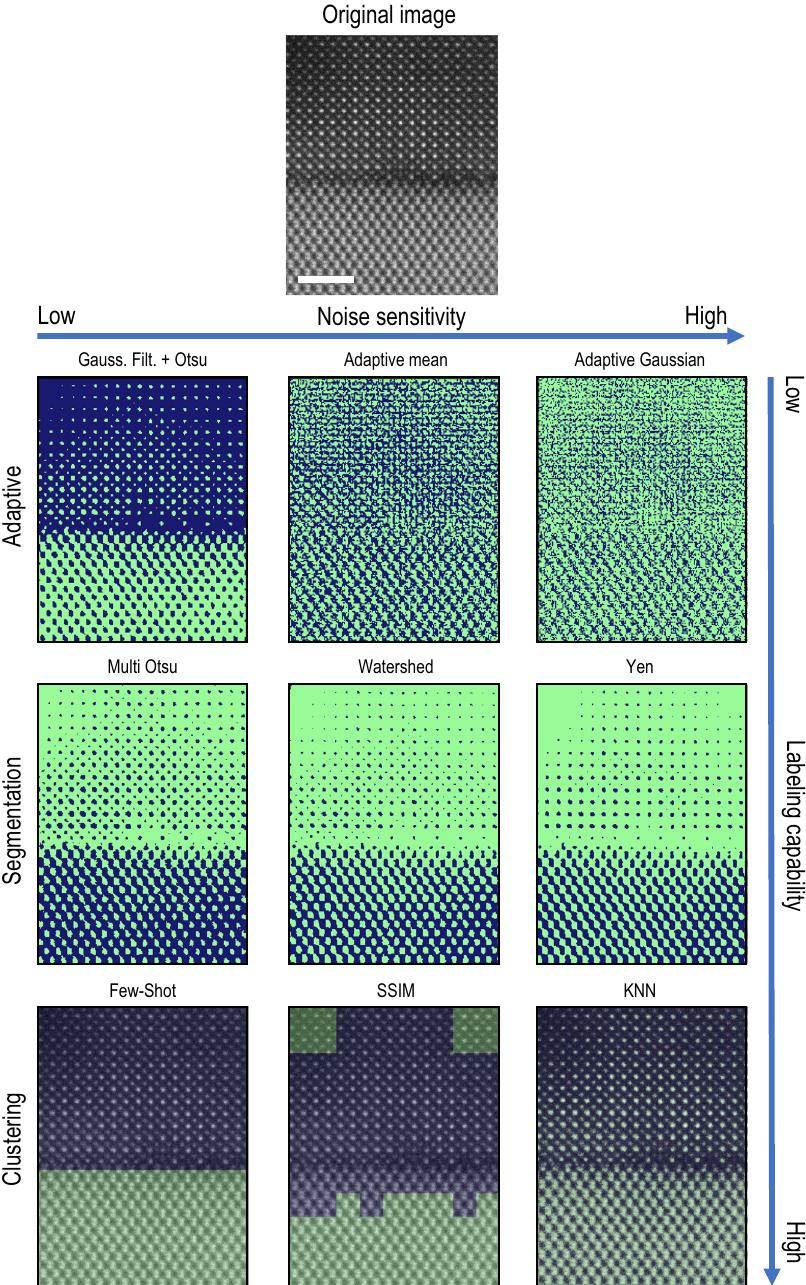
Fig. 3 Comparison of analysis techniques. An image from the STO/Ge system (top) is analyzed with a suite of image processing techniques with varying noise sensitivity and labeling capabilities. The thresholding techniques (top) typically separate background from foreground in an image. The strict segmentation techniques (middle) have the ability to separate the image further into multiple classes, though the classes are de fi ned solely on pixel intensity. The clustering techniques (bottom) separate an image into classes based calculated image properties such as a centroid (KNN), structural similarity threshold (SSIM), or a prototype (few-shot). Scale bar = 2 the two distinct micrographs. These approaches also typically technique appears to separate foreground pixels (light) from involve blurring fi lters and/or morphological operations 66 in order background (dark) relatively well. Moving beyond simple thresholding, we begin to look towards to remove pixels that are not a part of a larger group or shape. separating pixels into classes other than background and While shape edges are more de fi ned in the middle row of Fig. 3 foreground. The segmentation methods shown in Fig. 3 typically than in the top row, we note that the resulting segmentation still have the ability to separate intensities into multiple classes again appears to be background/foreground and misses the distinction de fi ned by the distribution of pixel intensities in the image. Two between micrograph structures. One obvious limitation of a direct implementation of these methods is that the resulting classes will always be based on intensity and not on the size or shape of the